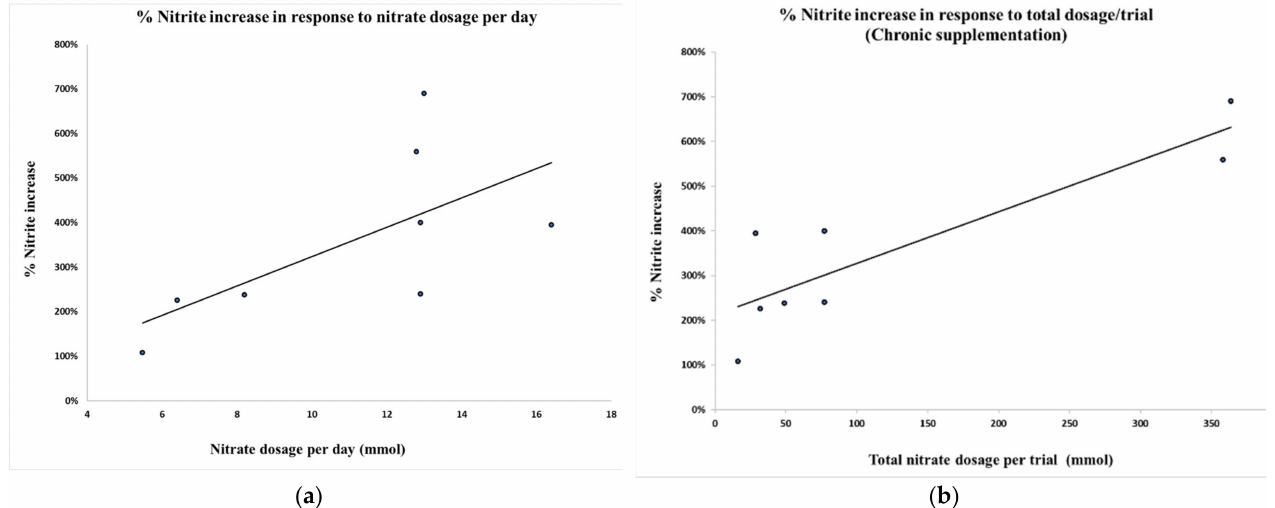
Figure 2. Percentage nitrite increase in response to ( a ) nitrate dosage per day ( r = 0.655, p = 0.078, N = 8) and ( b ) total nitrate dosage per trial ( r = 0.878, p = 0.004, N =